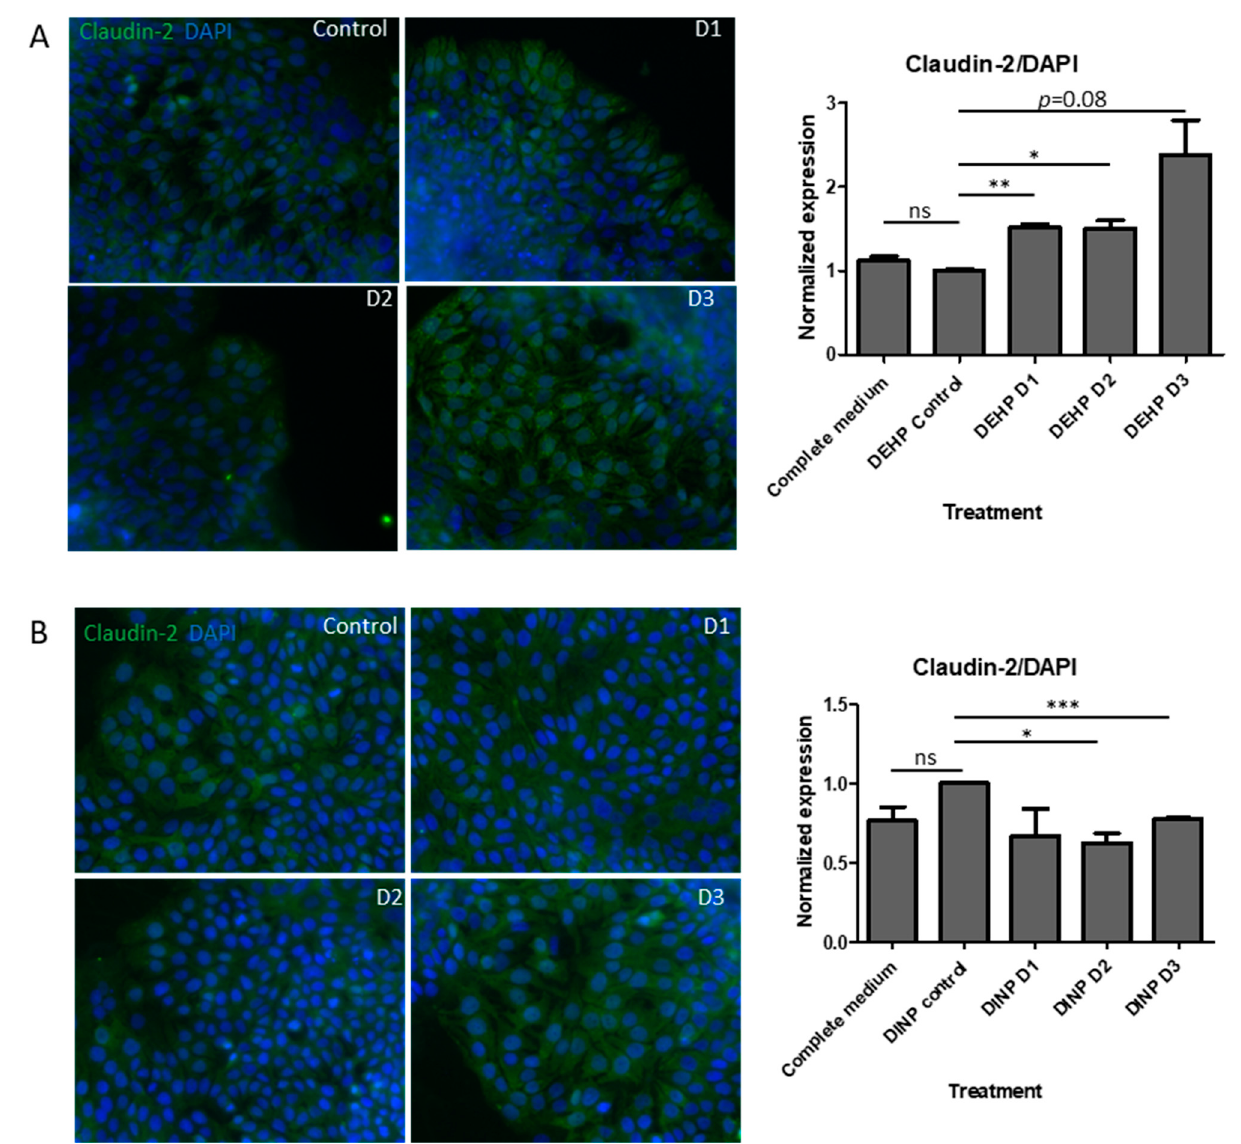
Figure 9. Claudin-2 expression in HT-29 after ( A ) DEHP and ( B ) DINP experimental luminal extract treatments. Expression of Claudin-2 in cells treated with luminal extracts from no plasticizer fermenter was normalized as 1. Image width = 330 μ m. t-test, ns: not significant, * p < 0.05, ** p < 0.01 and *** p < 0.005.